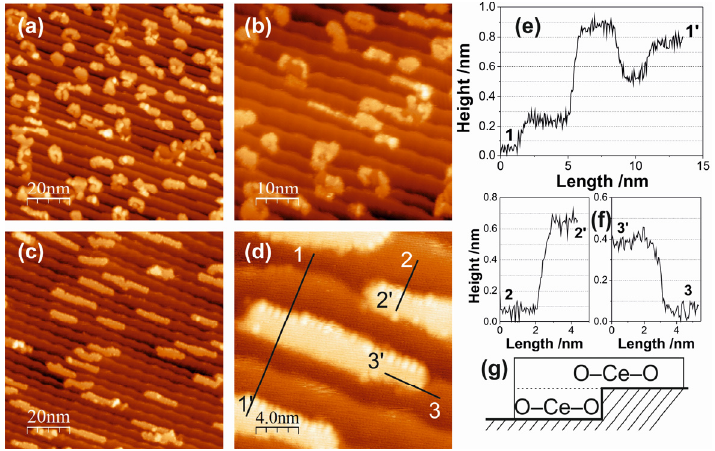
Figure 5. STM images of 0.14 ML ceria on Au(788): ( a , b ) Fabricated by reactive evaporation at 473 K in 1 × 10 − 8 mbar O 2 . ( a ) (100 × 100) nm 2 ; V S = 2.3 V; I T = 28.9 pA. ( b ) (50 × 50) nm 2 ; V S = 1.6 V; I T = 30.2 pA. ( c , d ) Fabricated by reactive evaporation at 473 K in 1 × 10 − 6 mbar O 2 . ( c ) (100 × 100) nm 2 ; V S = 2.0 V; I T = 24.1 pA. ( d ) (50 × 50) nm 2 ; V S = 2.0 V; I T = 24.1 pA. ( e , f ) Line scans along the solid lines 1-1´, 2-2´ and 3-3´ in image ( d ). ( g )